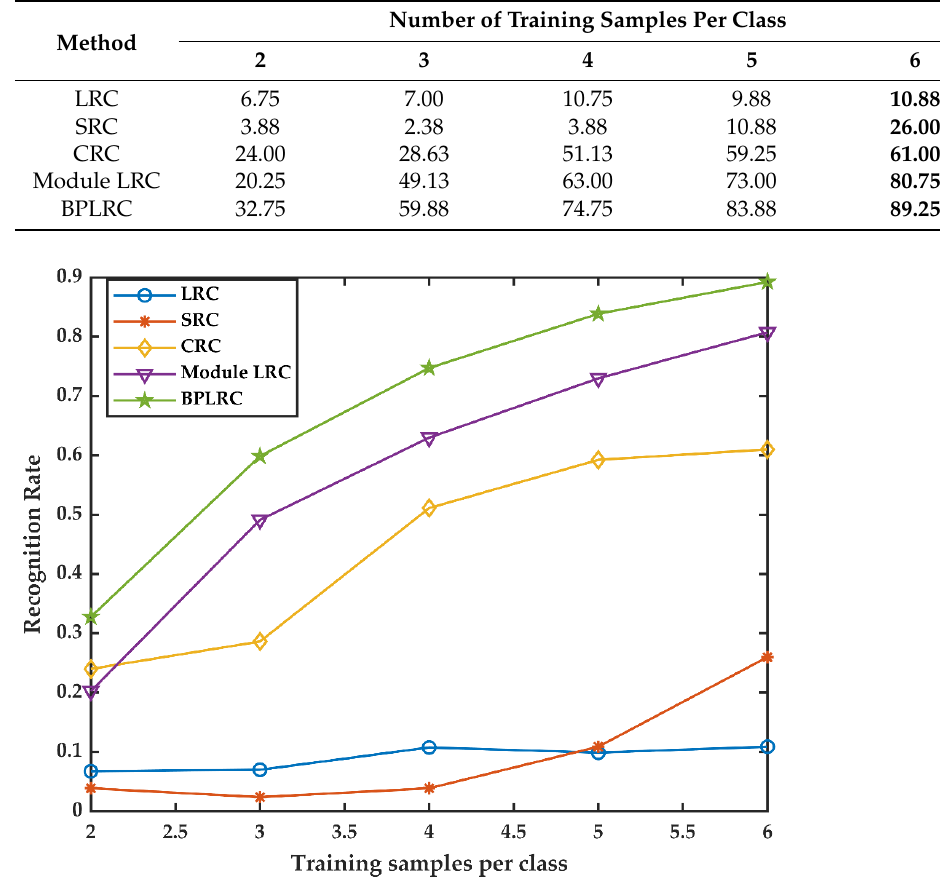
Figure 11. The relationship between the recognition rate of different methods for face images with scarves (the images were downsampled to 500 dimensions) and the number of training samples per class [authors’ own processing].